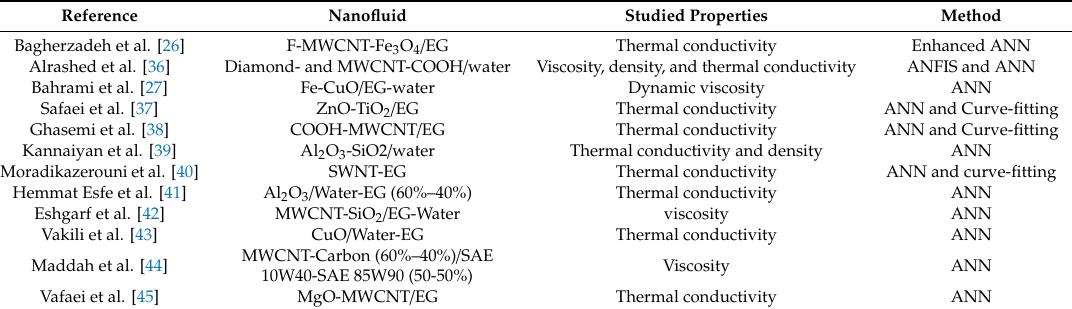
Table 1. A summary of the recently published literature on using neural networks in predicting the thermophysical properties of